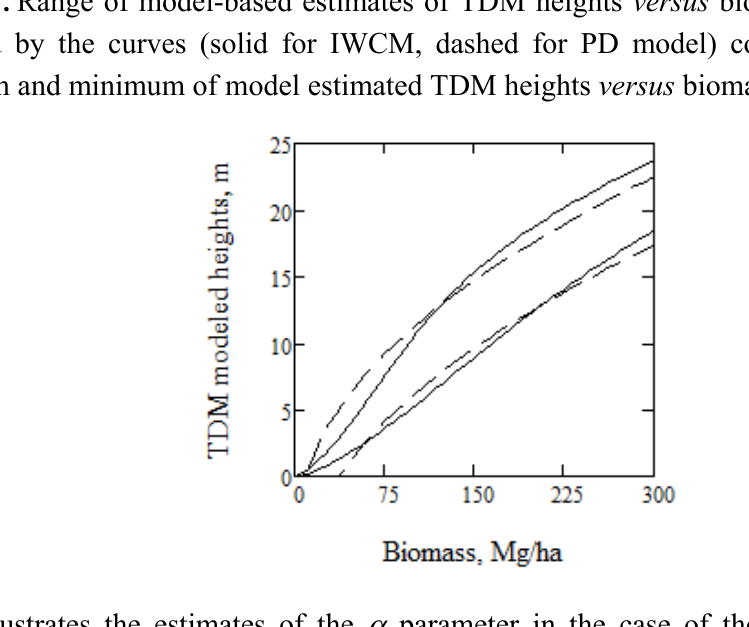
(  ) and  ( cf. Equation (4)) (o and  for gr veg